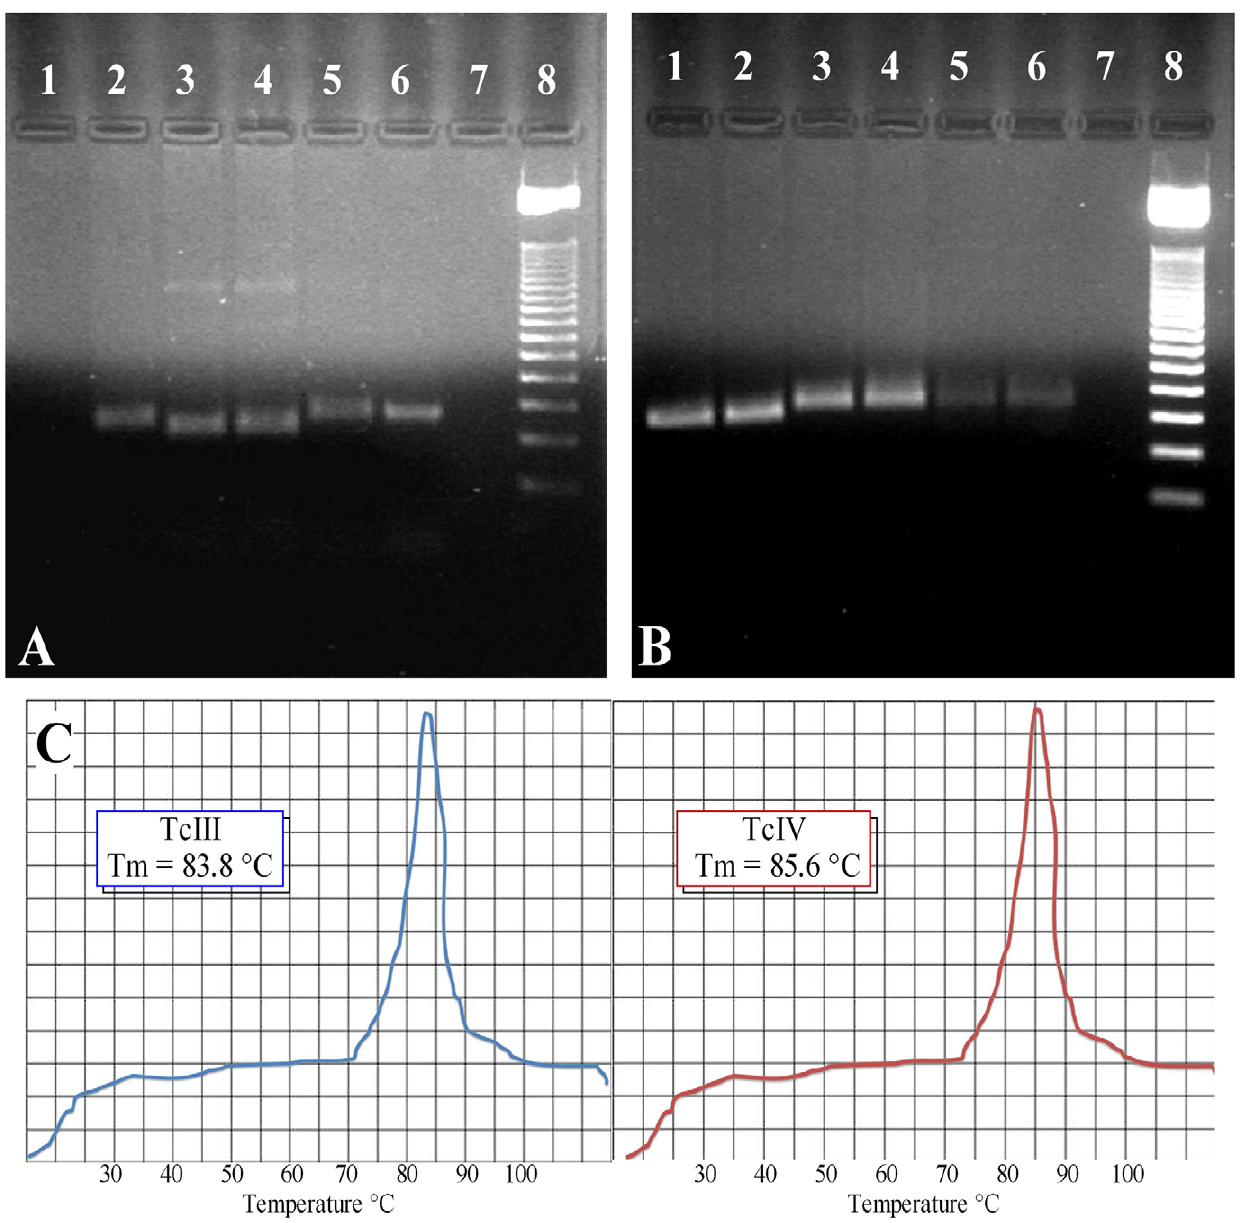
Figure 3. Amplification products of the 18S, 24S a rDNA and qPCR DNAst Tm peaks for the detection of TcIII and TcIV DTUs. Figure 3A. Amplification products in 2% agarose gels of D7 24S a rDNA region in T. cruzi . Lane 1. Negative control, Lane 2. Patient 54 TcIV, Lane